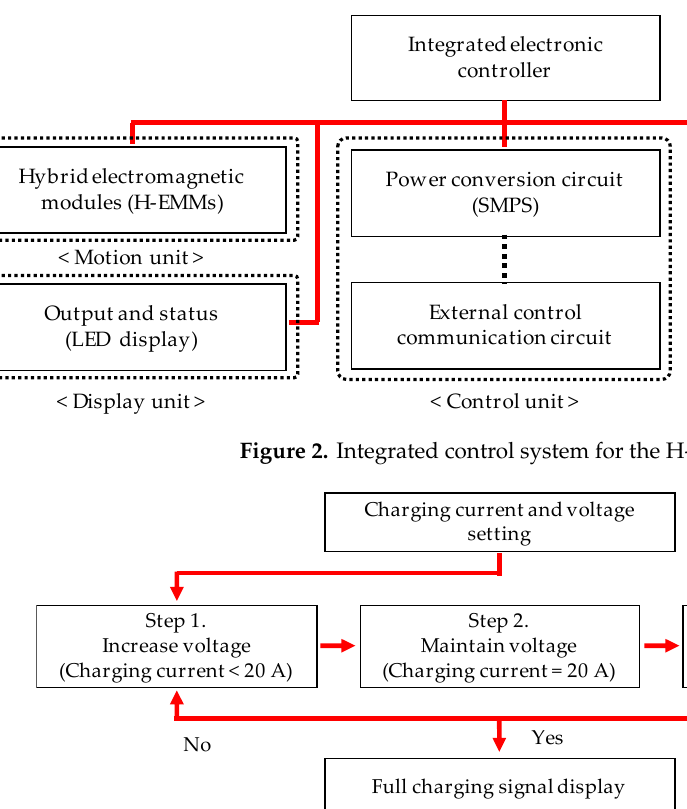
Figure 3. Charging process of the H-EMCS.